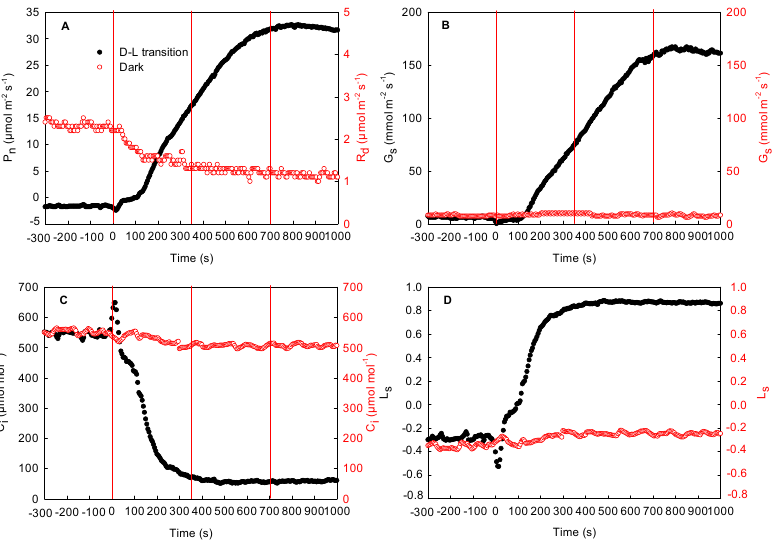
Figure 5. Effect of local illumination on the respiration rate of the adjacent region in the same maize leaves. ( A ) photosynthetic induction under the dark–light transition in the local regions or respiration in darkness in the adjacent region; ( B ) stomatal conductance under the dark–light transition in the local regions or under the darkness in the adjacent region; ( C ) intercellular CO 2 concentration under the dark–light transition in the local regions or under the darkness in the adjacent region; ( D ) stomatal limitation under the dark–light transition in the local regions or in darkness in the adjacent region. C i , intercellular CO 2 concentration; D–L transition, dark–light transition; G s , stomatal conductance; L s , stomatal limitation; P n , photosynthetic rate; R d , respiration in darkness.